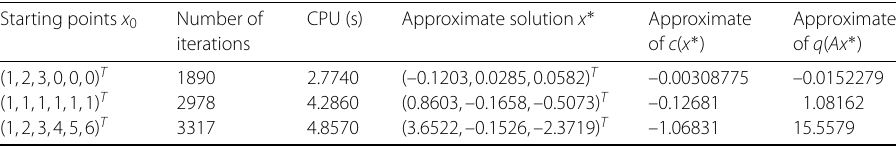
Table 2 Results for Example 5.4 using Qu and Xiu method in [7]